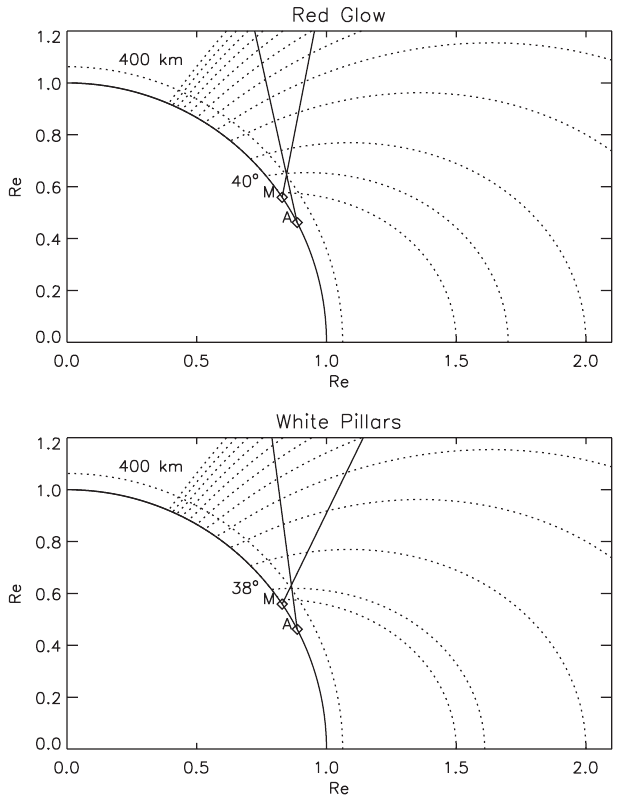
Fig. 4. Observation geometry of (top) red glow and (bottom) white pillars in the geomagnetic coordinate by Memambetsu Magnetic Observatory ( M , 34 (cid:1) magnetic latitude) and Aikawa Weather Station ( A , 27.5 (cid:1) magnetic latitude). The top panel shows the top part of red glow with 45 (cid:1) elevation angle at M and with 15 (cid:1) elevation angle at A . The bottom panel shows the top part of white pillars with 60 (cid:1) elevation angle at M and with 20 (cid:1) elevation angle at A .